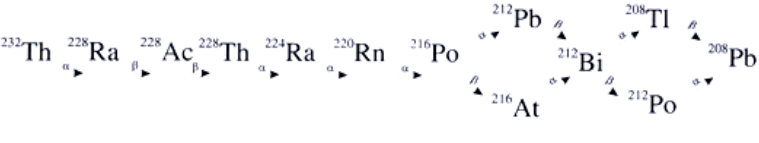
Figure 1. Chain of radioactive transformations of 232 Th.